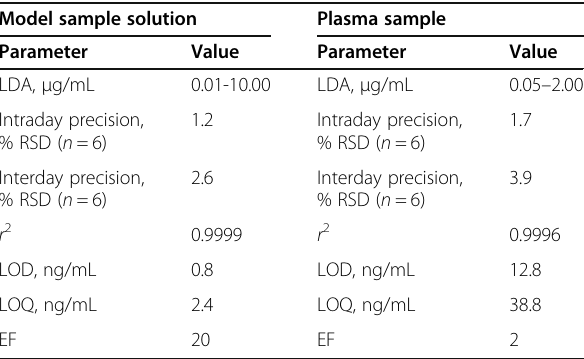
Table 1 Analytical performances of the proposed method at model sample solution and plasma matrix Model sample solution